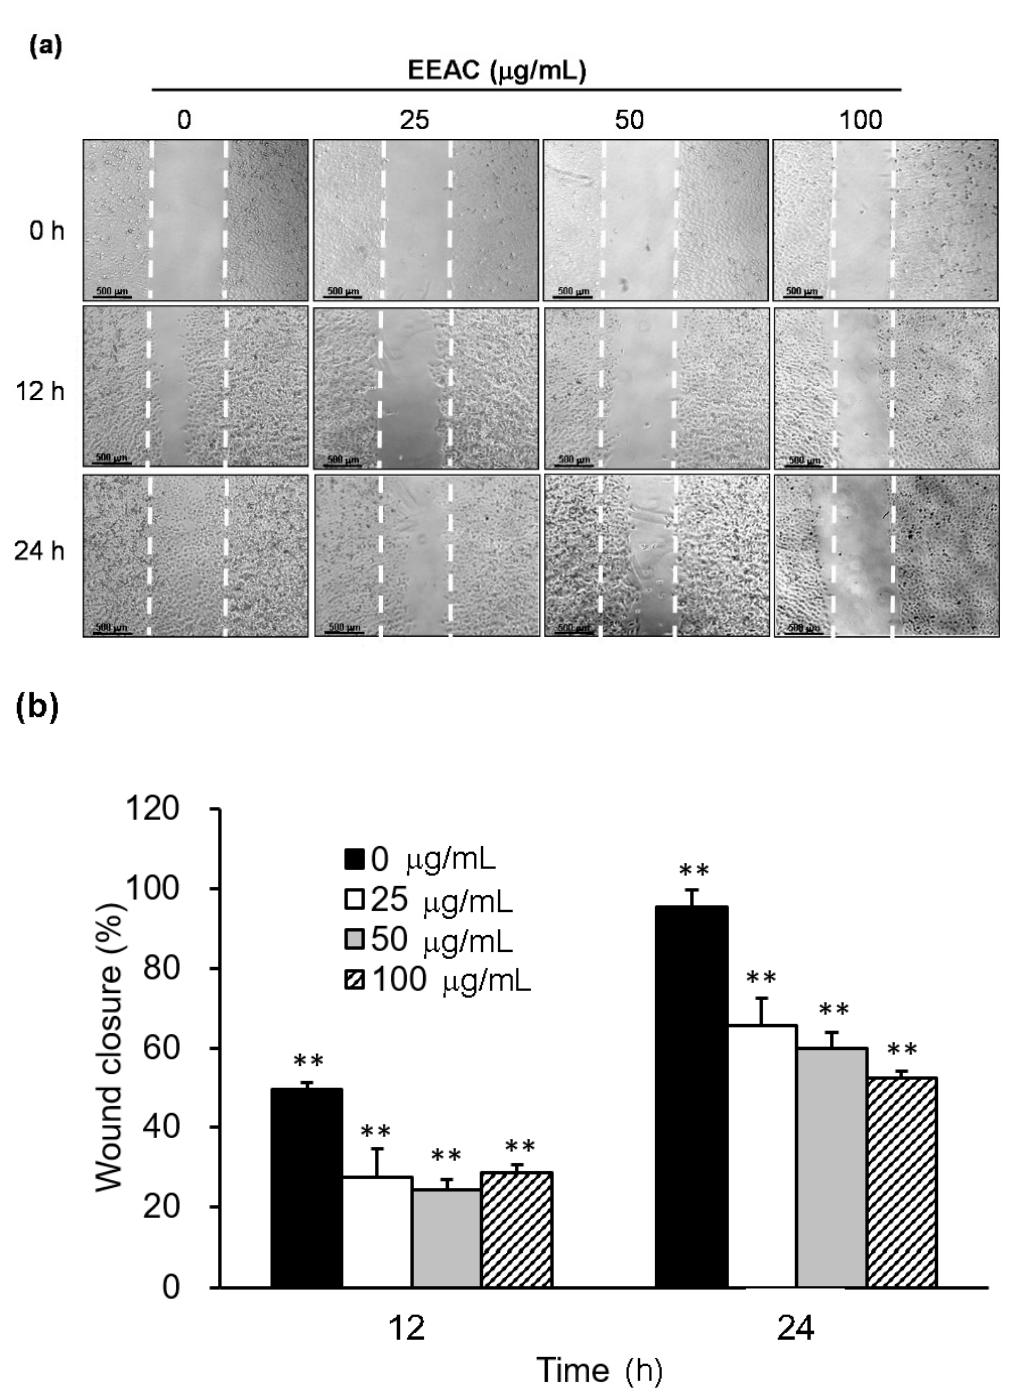
Figure 3. Inhibition of cell migration by EEAC in A549 cells. Cells were stimulated with 10% FBS to induce cell migration and co-incubated with various concentrations of EEAC. The pictures were acquired after 0, 12 and 24 h treatment of EEAC ( a ). Migration inhibition was presented as the percentage of wound closure by calculating the cell-free gap of each group compared to those at initial time ( b ). ** p < 0.01 compared to those of individual group at initial time.